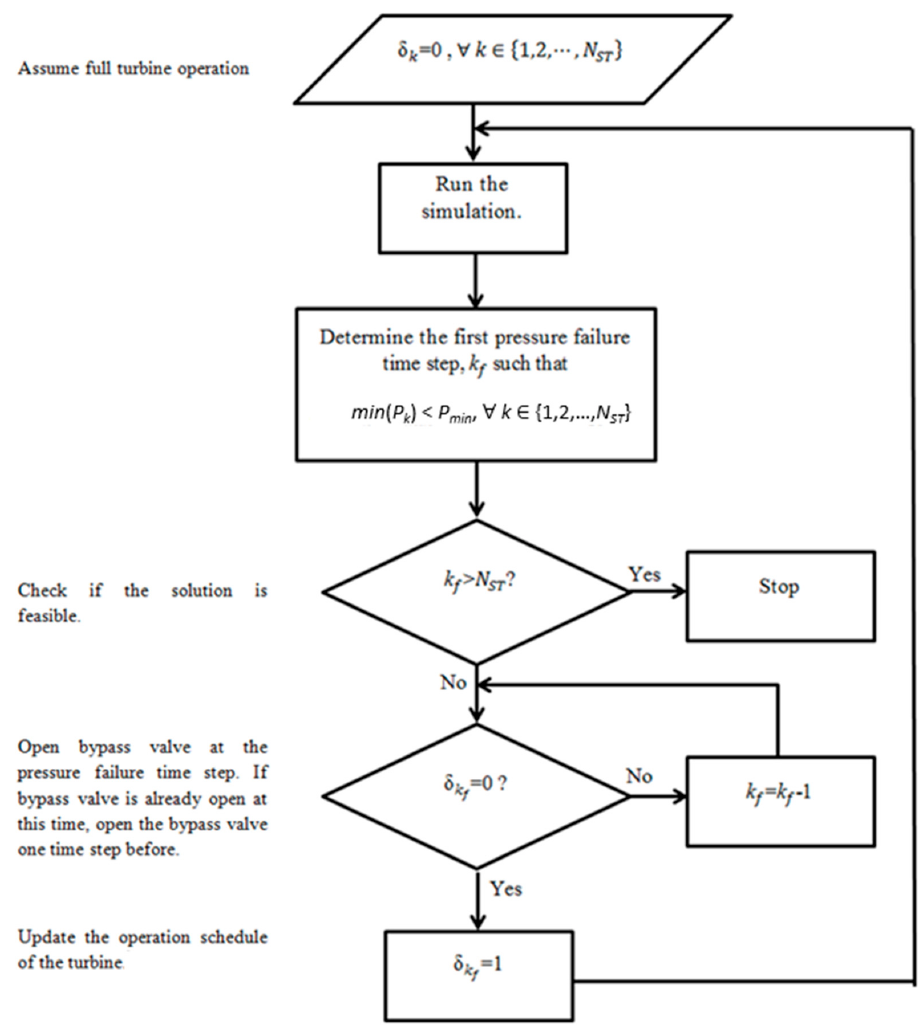
Figure 2. Process of obtaining a smart seed.